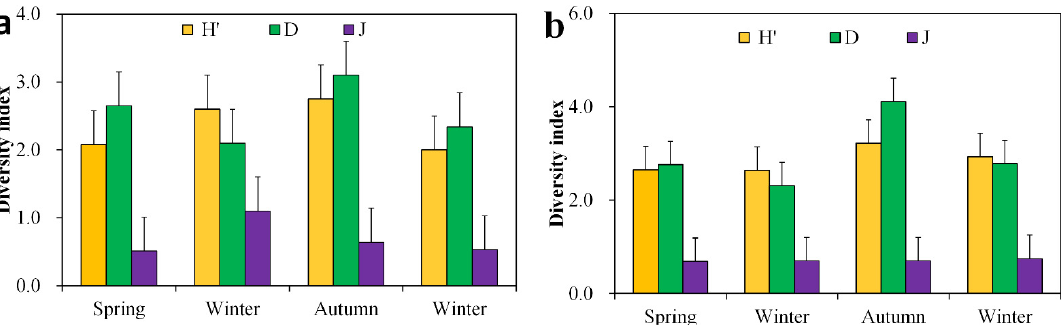
Figure 5. Seasonal distribution of zooplankton diversity index in Lake Chen Yao ( a ) and Lake Feng Sha ( b ).